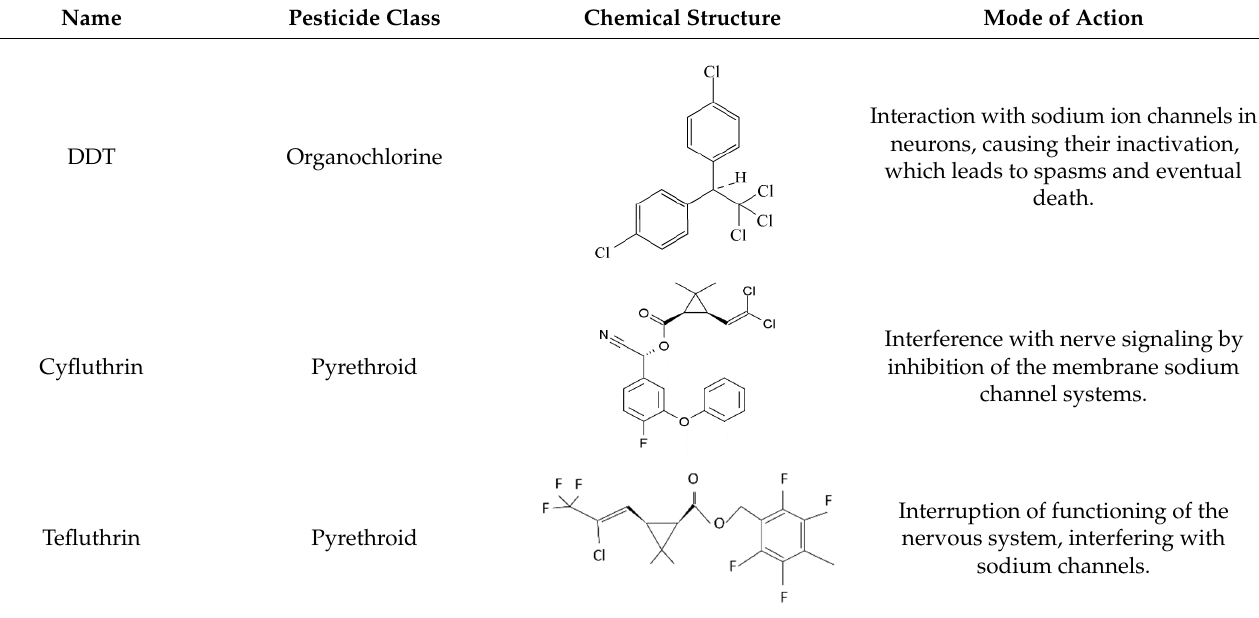
Table 3. Classification of the most common insecticides used in agricultural soil.